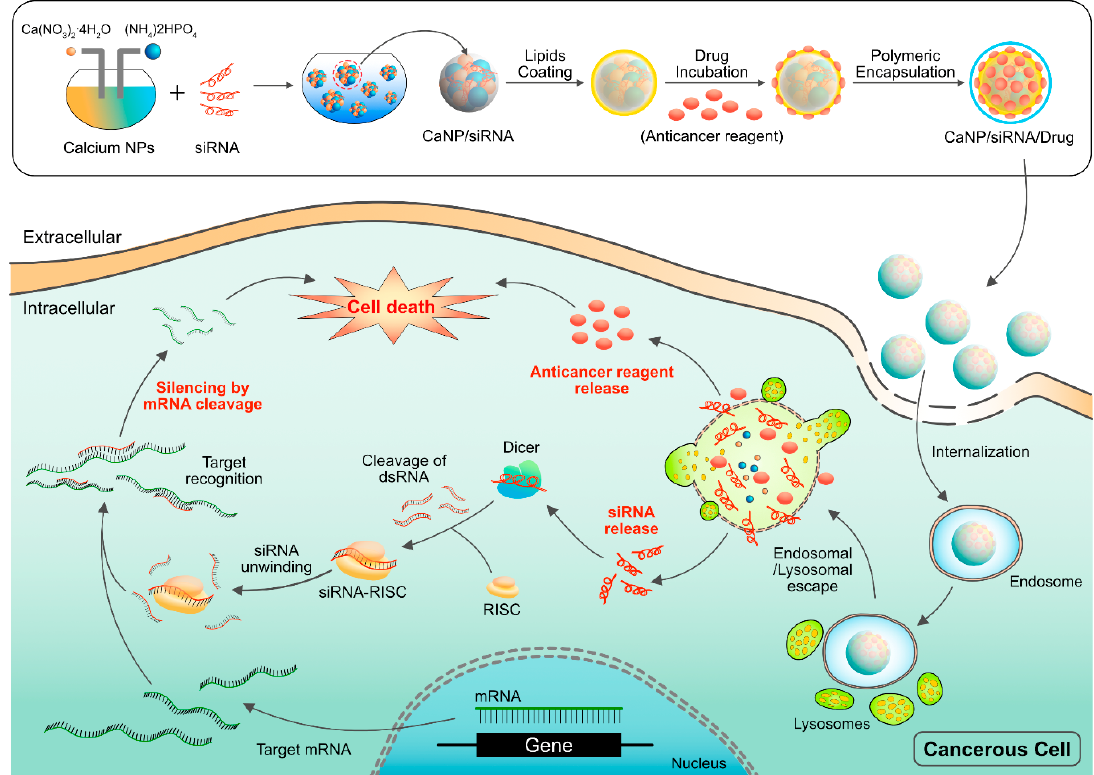
Figure 8. Combined nano-therapy strategy of CaP nanoparticles containing siRNA and anticancer reagent and their therapeutic effect in cancerous cell. CaP nanoparticles which were assembled with siRNA targeting specific genes is coated with lipids, followed by co-incubation with anticancer drug. The obtained CaNPs/siRNA/DOX are encapsulated by polymers. Internalized CaNPs/siRNA/DOX into cancerous cell are dissolved in endosomal pH through endosomal/lysosomal escape and then released to cytoplasm. Then, siRNA is processed by dicer and RISC system in cytosol and recognize target mRNA to silence the gene expression. Simultaneously, anticancer drug released functions regarding its biological mechanism. Ultimately, both are purposed to induce cell death.